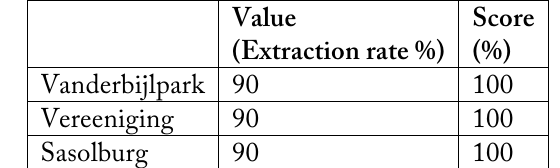
Table 2 Resource component